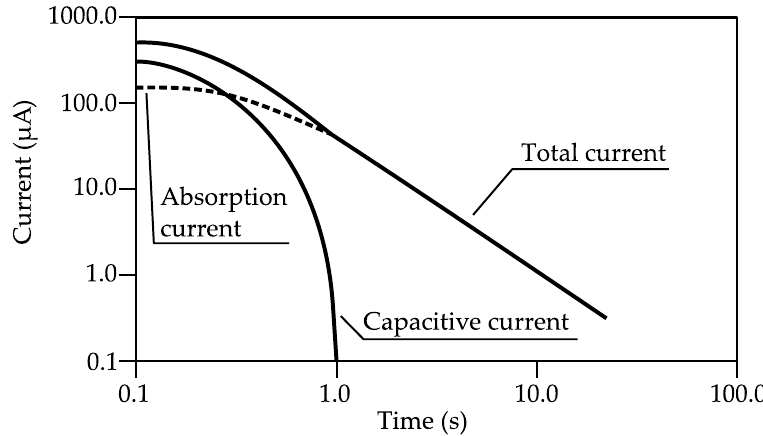
Figure 5. Currents in the insulating system during the discharge of the dielectric.